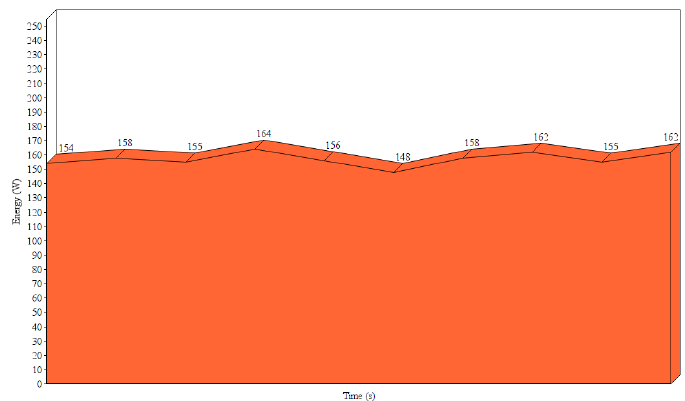
Figure 25. NVIDIA Tesla K40 m GPU energy consumption on full usage (avg. 13